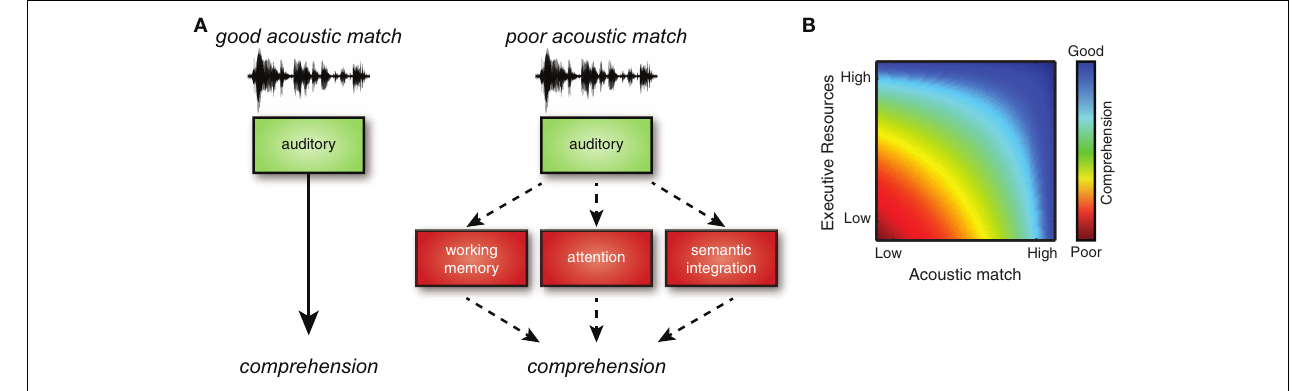
FIGURE 1 | (A) Speech signals that match listeners’ perceptual expectations are processed relatively automatically, but when acoustic match is reduced (for example, due to noise or unfamiliar accents), additional executive resources are needed to compensate. (B) Executive resources are recruited in proportion to the degree of acoustic mismatch between incoming speech and